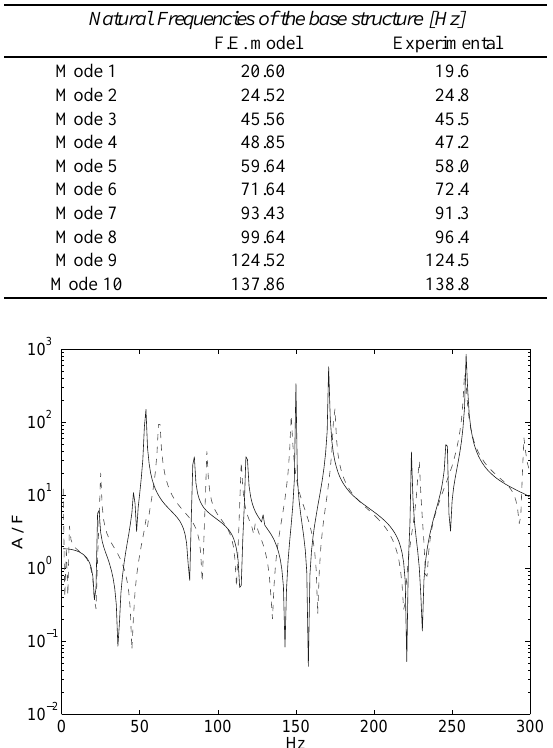
Table 3 Finite Element vs. experimental natural frequencies of the base